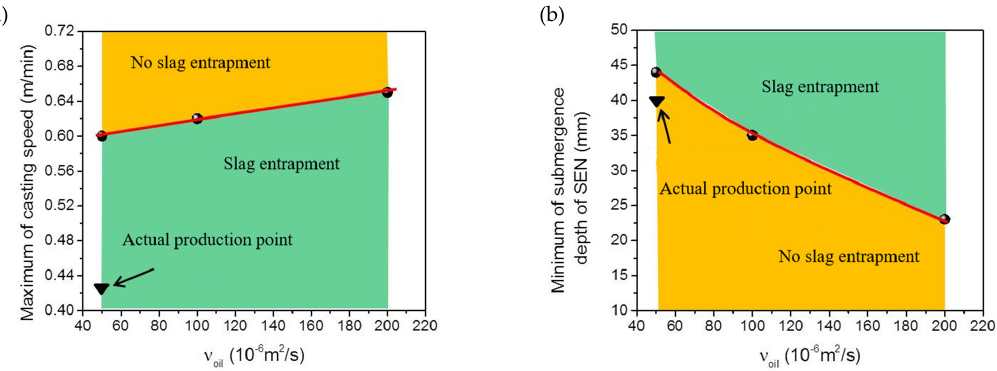
Figure 10. Critical conditions of oil droplet involvement. ( a ) The critical water model casting speed of oil droplet involvement when the nozzle immersion depth is 50 mm. ( b ) The critical nozzle im-